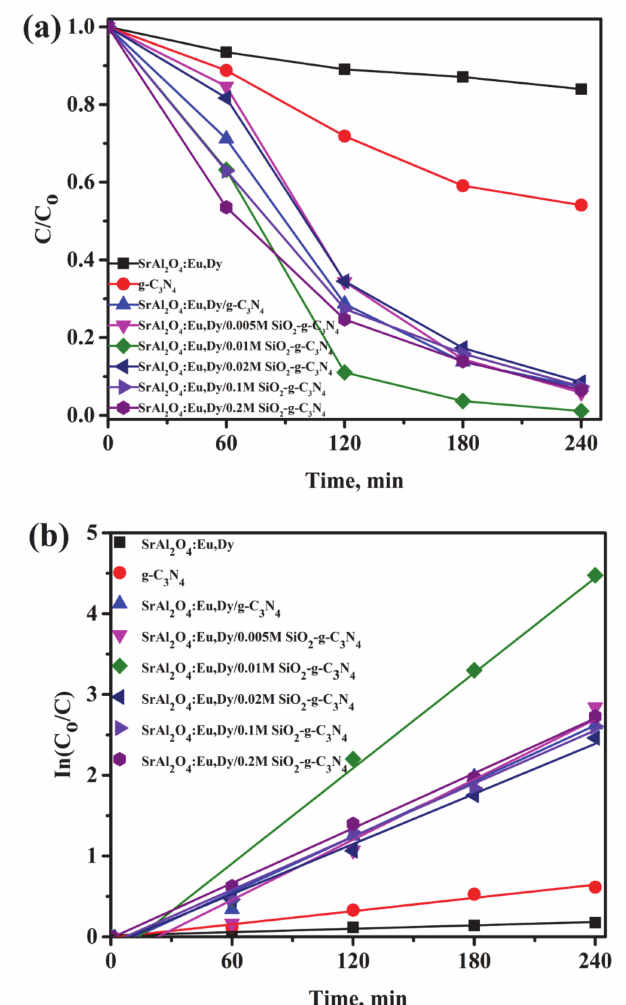
Figure 8. Photo-degradation e ffi ciency ( a ) and rate of reaction ( b ) for 50 wt.% g-C 3 N 4 supported on SrAl 2 O 4 :Eu,Dy / SiO 2 in MB solutions under UV-light